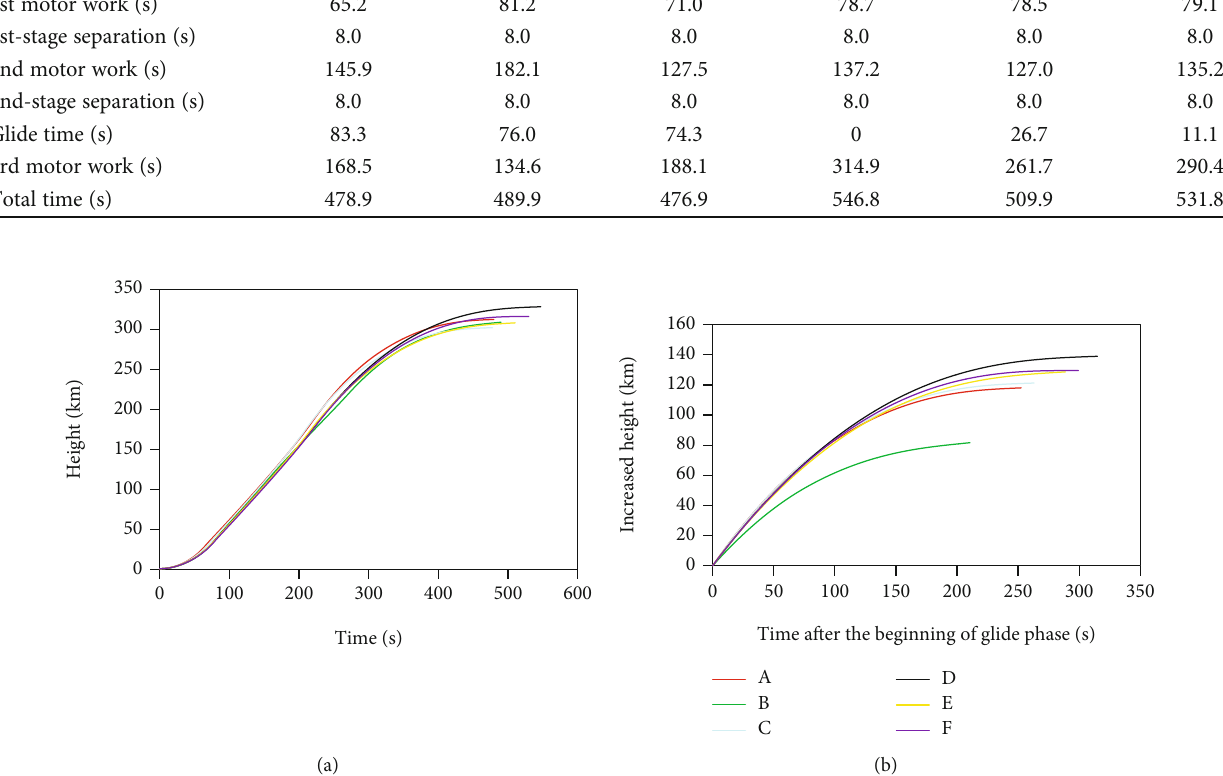
Figure 13: Height-time curve of di ff erent cases: (a) whole fl ight; (b) glide phase and 3rd-stage working